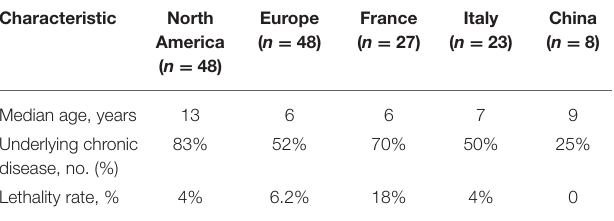
TABLE 1 | Characteristics of severe acute respiratory syndrome coronavirus 2 (SARS-CoV-2) positive children admitted to the pediatric intensive care units in different